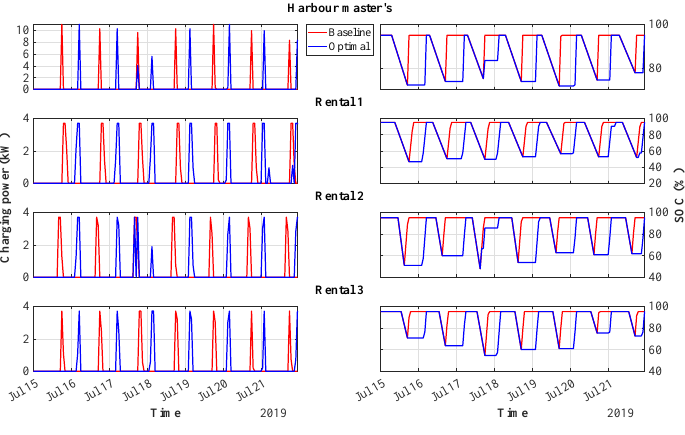
Figure 6. Baseline and optimal car charging